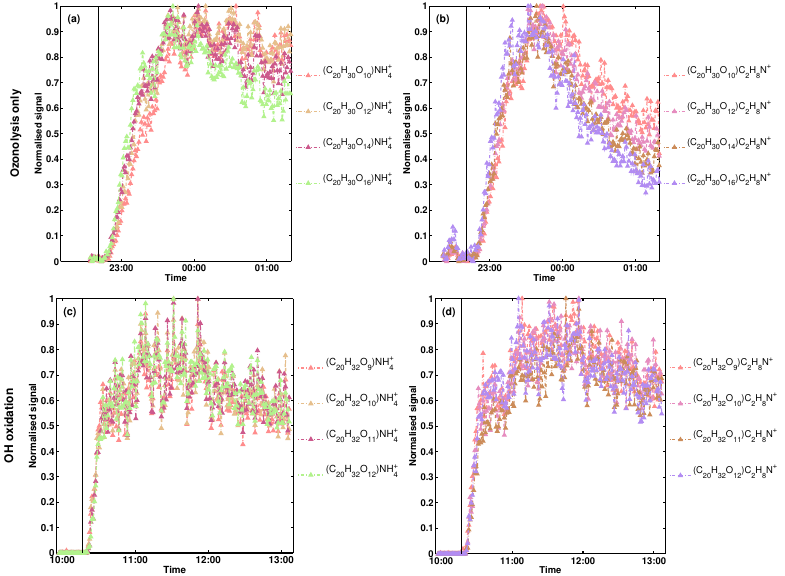
Figure 6. Time series of observed positive clusters containing C 20 H 30 , 32 O z oxidised compounds bound to NH + 4 (a and c) and C 2 H 8 N + (b and d) for α -pinene pure ozonolysis (a–b) and pure OH oxidation (c–d). The vertical black line marks the beginning of the experiment.